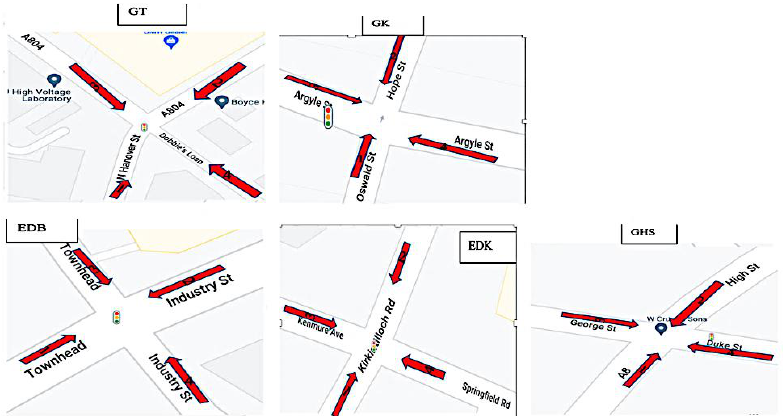
Figure 2. Directions of traffic flow at the monitoring locations.